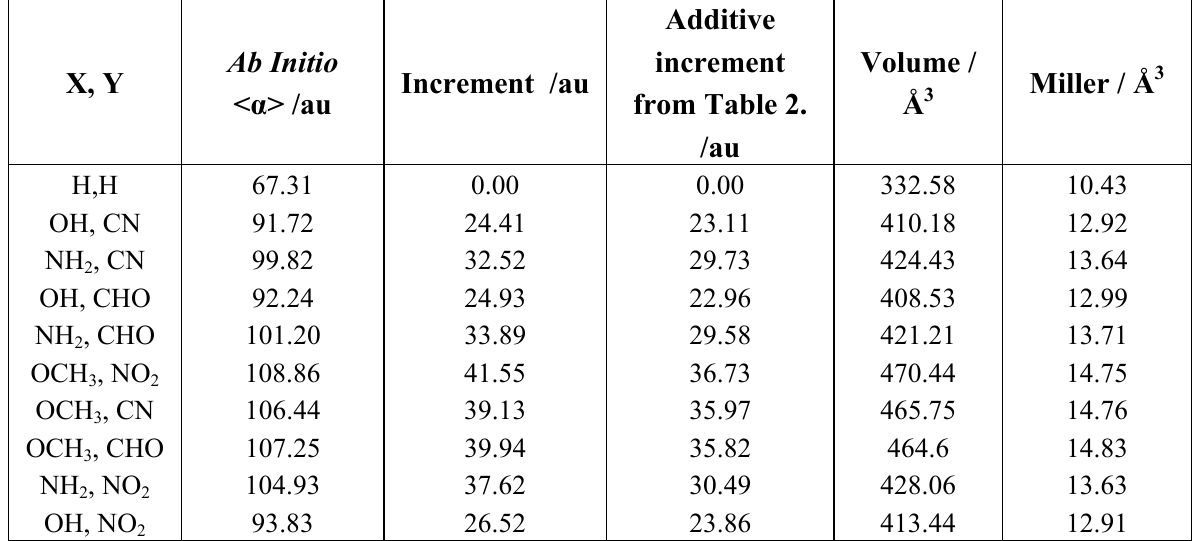
Table 4. Various quantities for the X-C